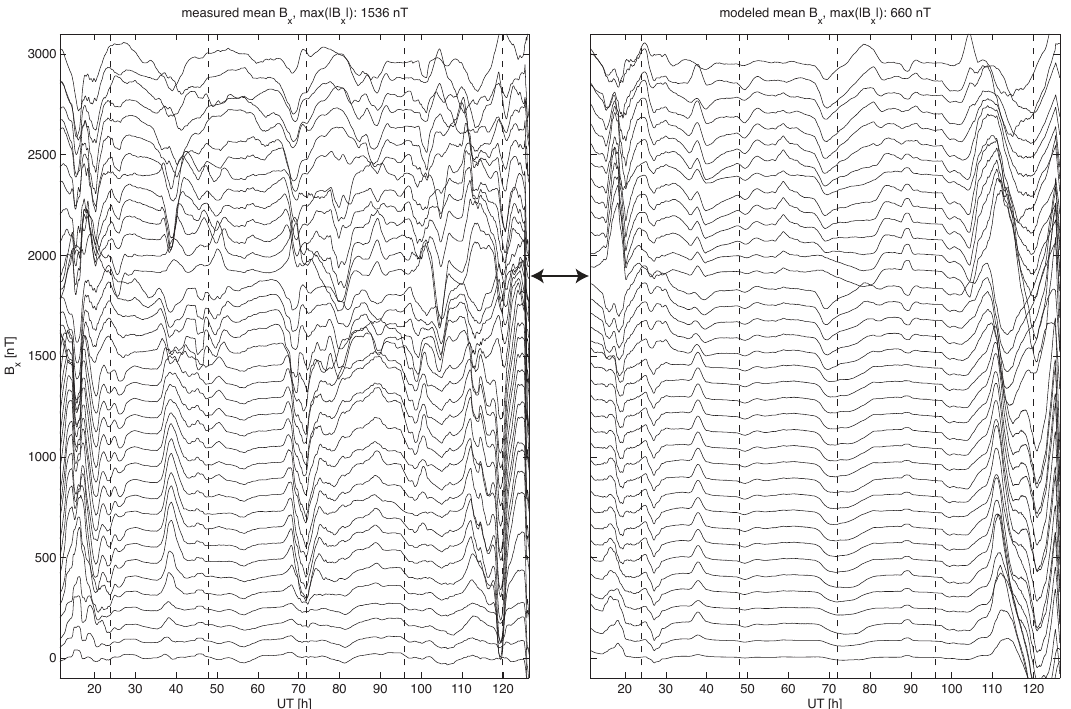
Fig. 5. Average magnetic field fluctuations for data shown in Fig. 4. The averaging was carried out in moving windows having length of